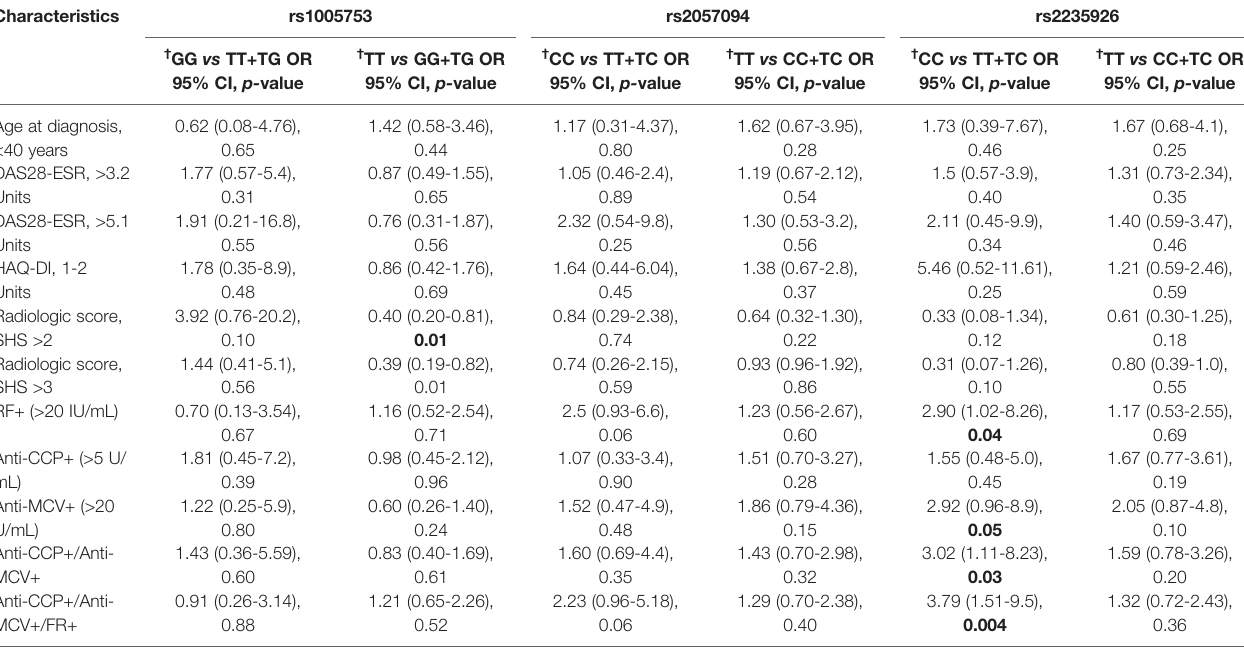
TABLE 6 | Association of PADI2 SNPs on the clinical characteristics in RA patients. Characteristics